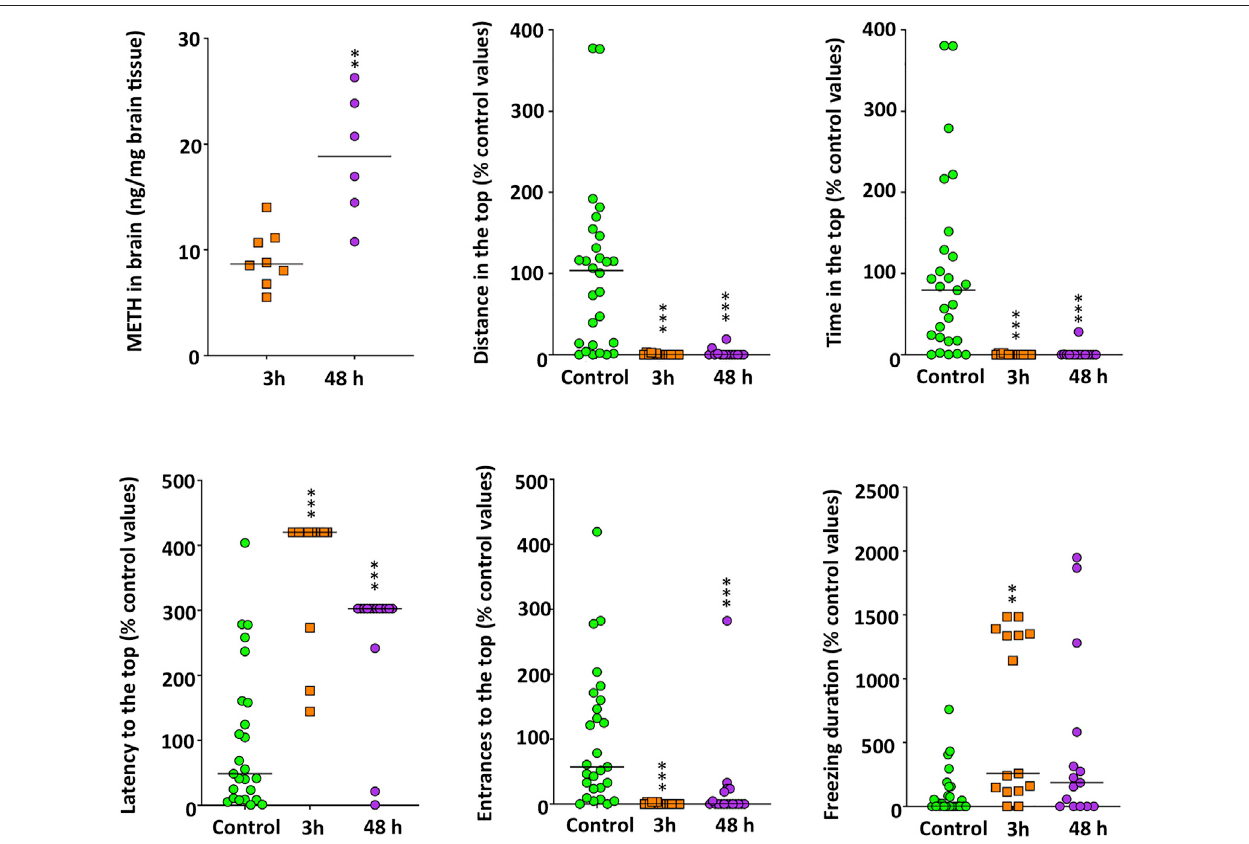
FIGURE 1 | Time-dependent increase in methamphetamine brain levels in adult zebra fi sh waterborne exposed to 40 mg/L methamphetamine (METH) for 3 and 48 h and anxiety-like behavior, assessed in standard 6-min novel tank test (NTT) of zebra fi sh exposed tothe sameconcentration and times. Data from each experiment werenormalizedto the corresponding control values. The combined data isreported asscatter plot withthe median ( n (cid:2) 6 – 8for METH levels in thebrain and n (cid:2) 14 – 15 fortheNTTresults),** p < 0.01,*** p < 0.001;Student ’ s t -testforMETHlevelsinbrainandKruskalWallistestwithBonferronicorrectionforNTTendpoints.Datafrom two independent